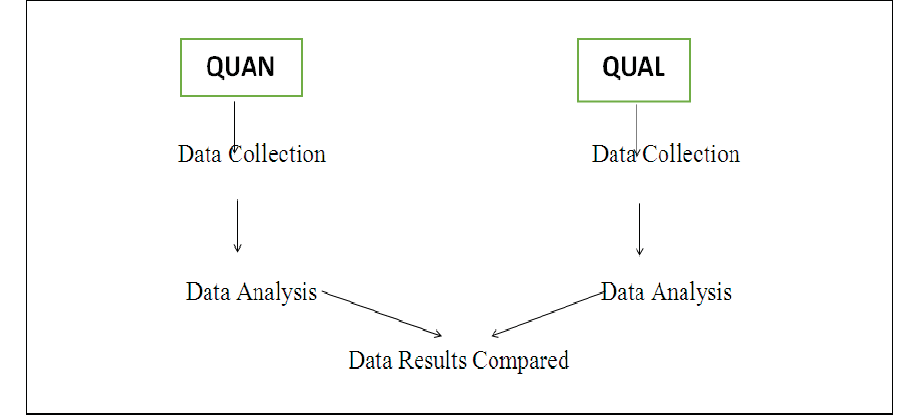
Fig. 1. The mixed method concurrent triangulation